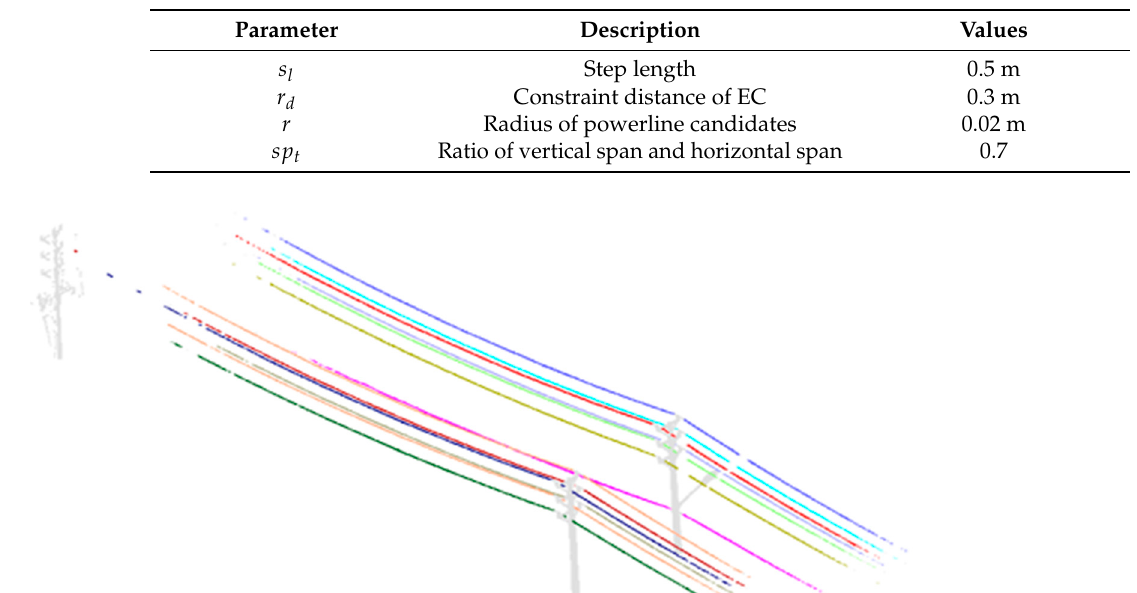
Table 2. Parameters in proposed method.